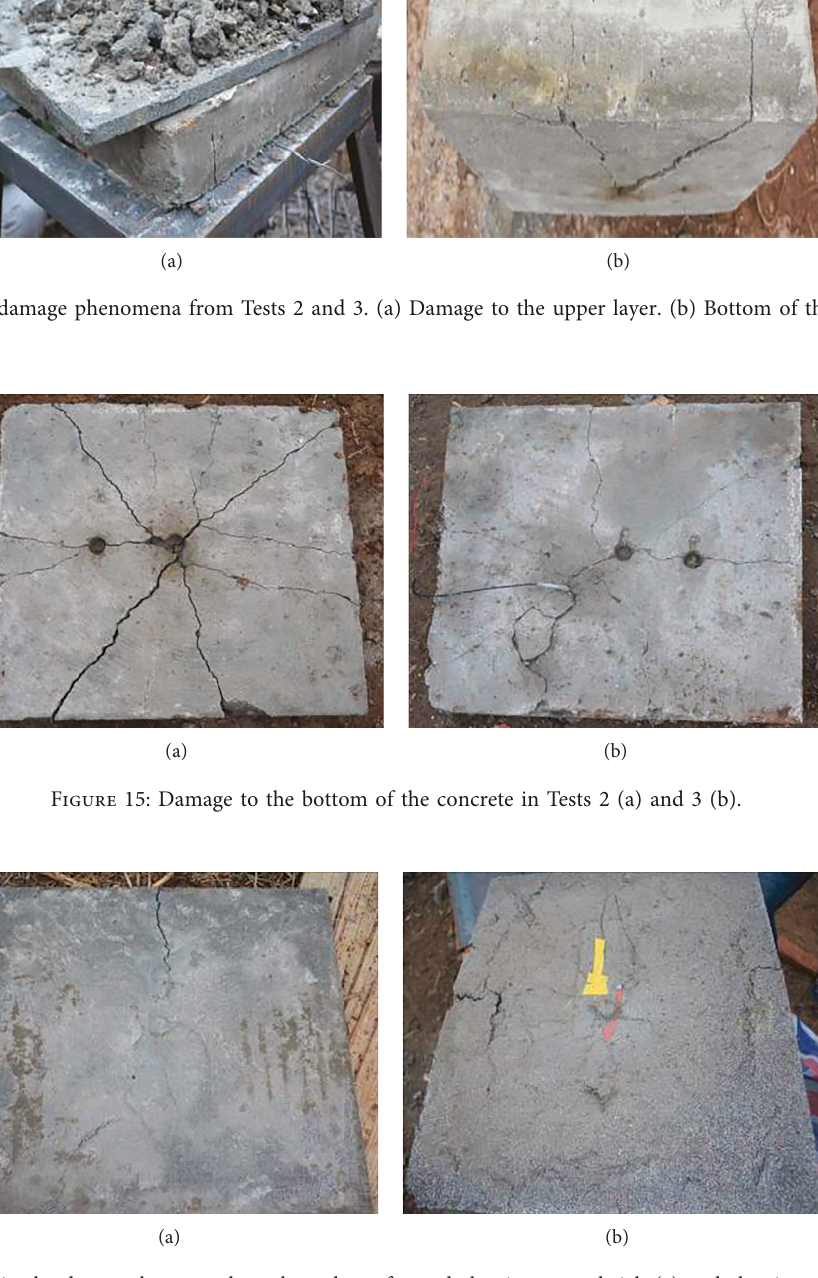
Figure 16: Differences in the damage between the polyurethane-foamed aluminum sandwich (a) and aluminum foam sandwich